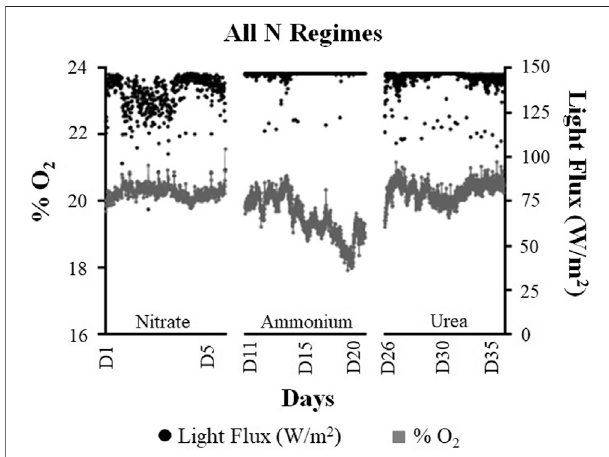
FIGURE 3 | Comparison of the average oxygen (% O 2 ) and light fl ux (W/m 2 ) values quanti fi ed during the three nitrogen regimes of the ground demonstrationstudy.Forthegraphicalrepresentationofdata,thevalueshave been reported as the 15-min average of each analyte.